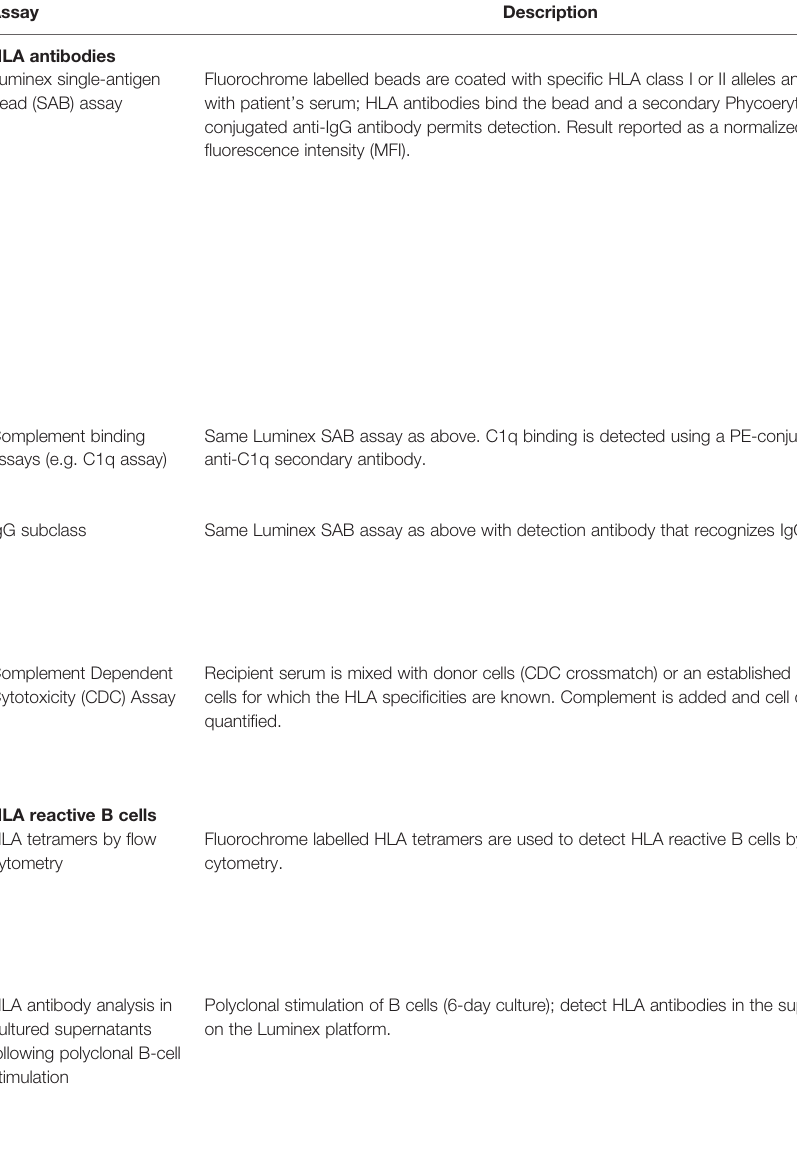
TABLE 1 | Assays to detect & characterize allosensitization (38 –